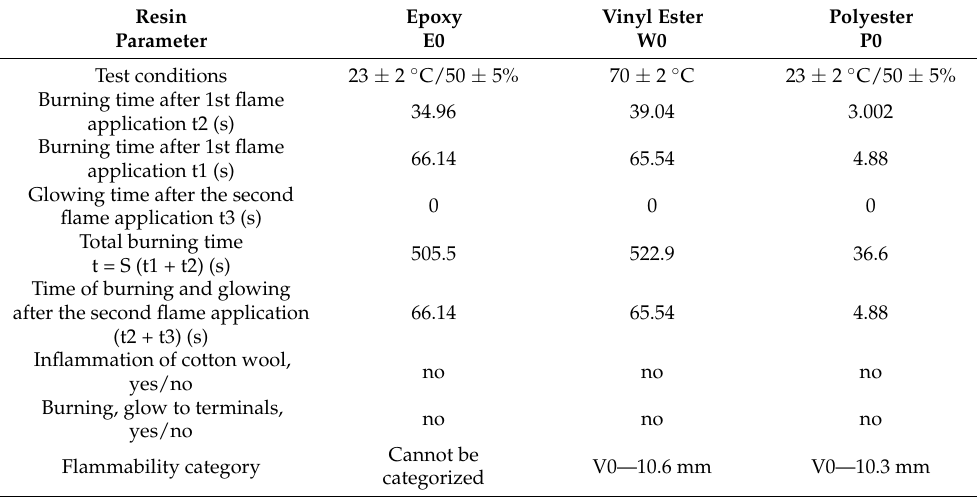
Table 2. Flammability